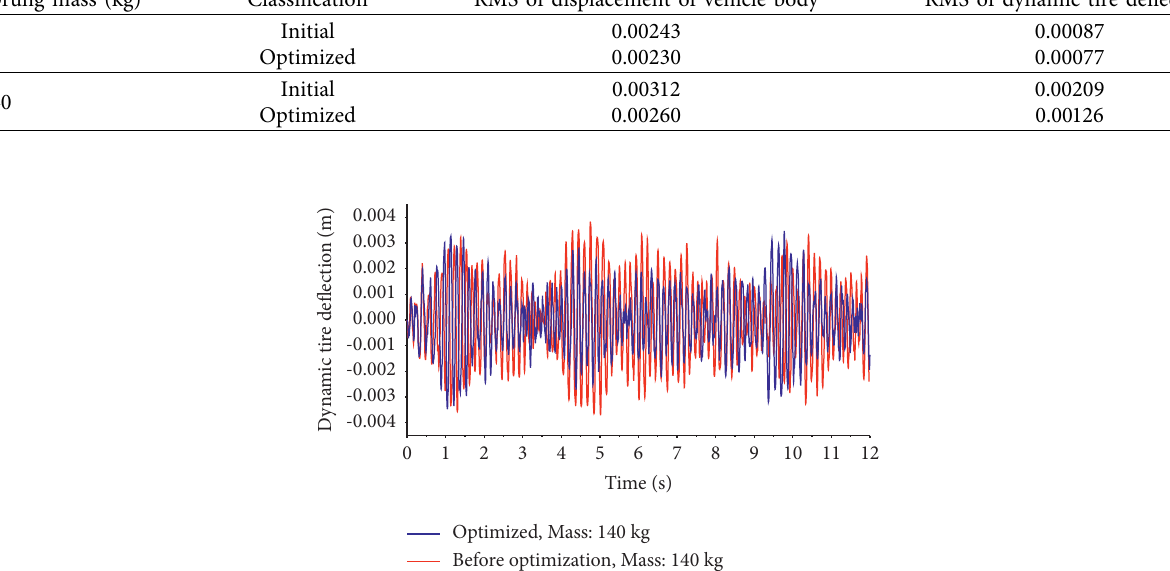
Figure 20: Comparison of the optimization results of the time-domain dynamic tire deflection at a 140kg load.